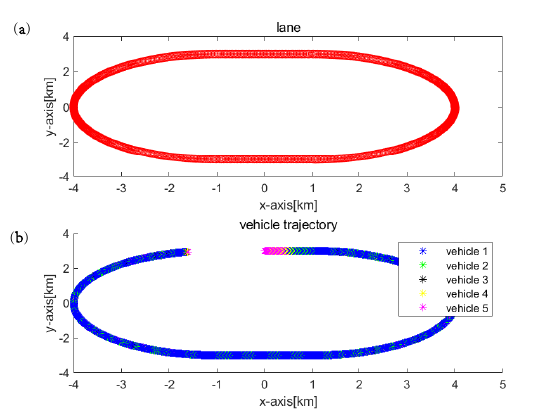
Figure 2. ( a ) The lanes that the trucks follow. In addition, ( b ) shows the trajectory of every